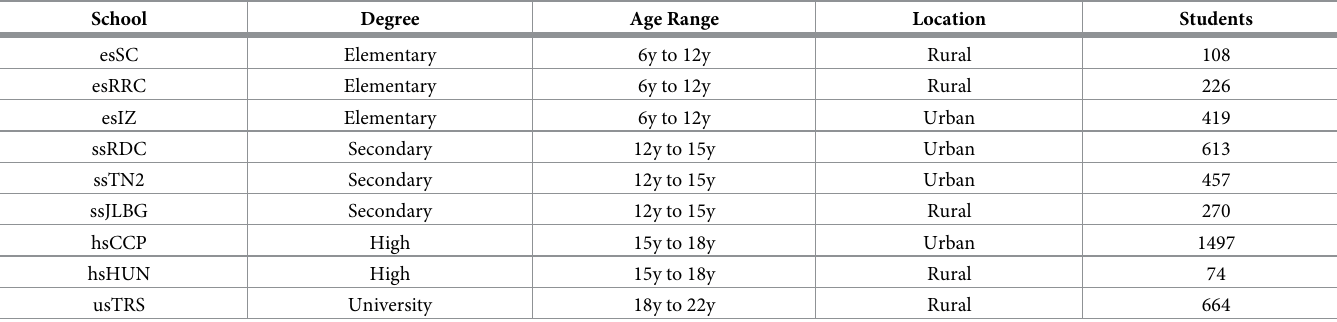
Table 1. Characteristics of the schools that participated in this